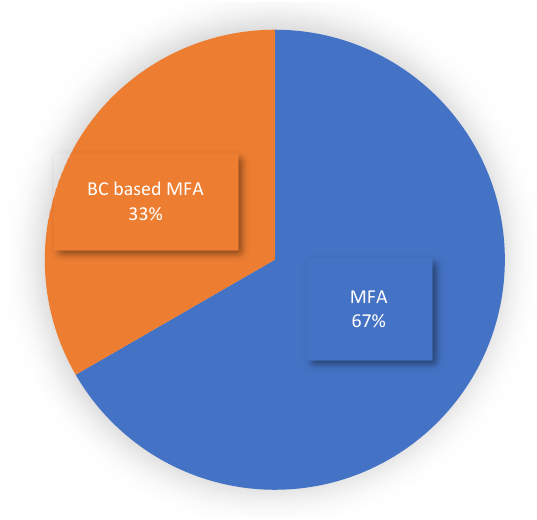
Figure 7. Adaptation of different security mechanisms for 3G/4G or 5G networks.